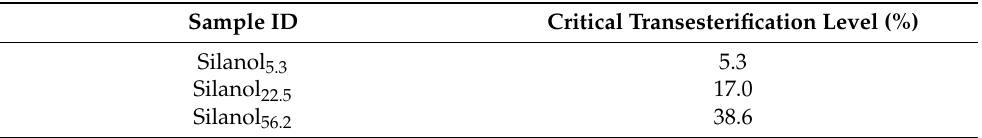
Figure 6. 1 H-NMR spectra of first transesterification product of ( a ) Silanol 5.3 , ( b ) Silanol 22.5 , and ( c ) Silanol 56.2 reacted with DPC under the action of 100 ppm KOH at 180 ◦ C. Table 2. Critical transesterification level of silanol-terminated PDMS with different chain lengths reacted with DPC to reach two-phase